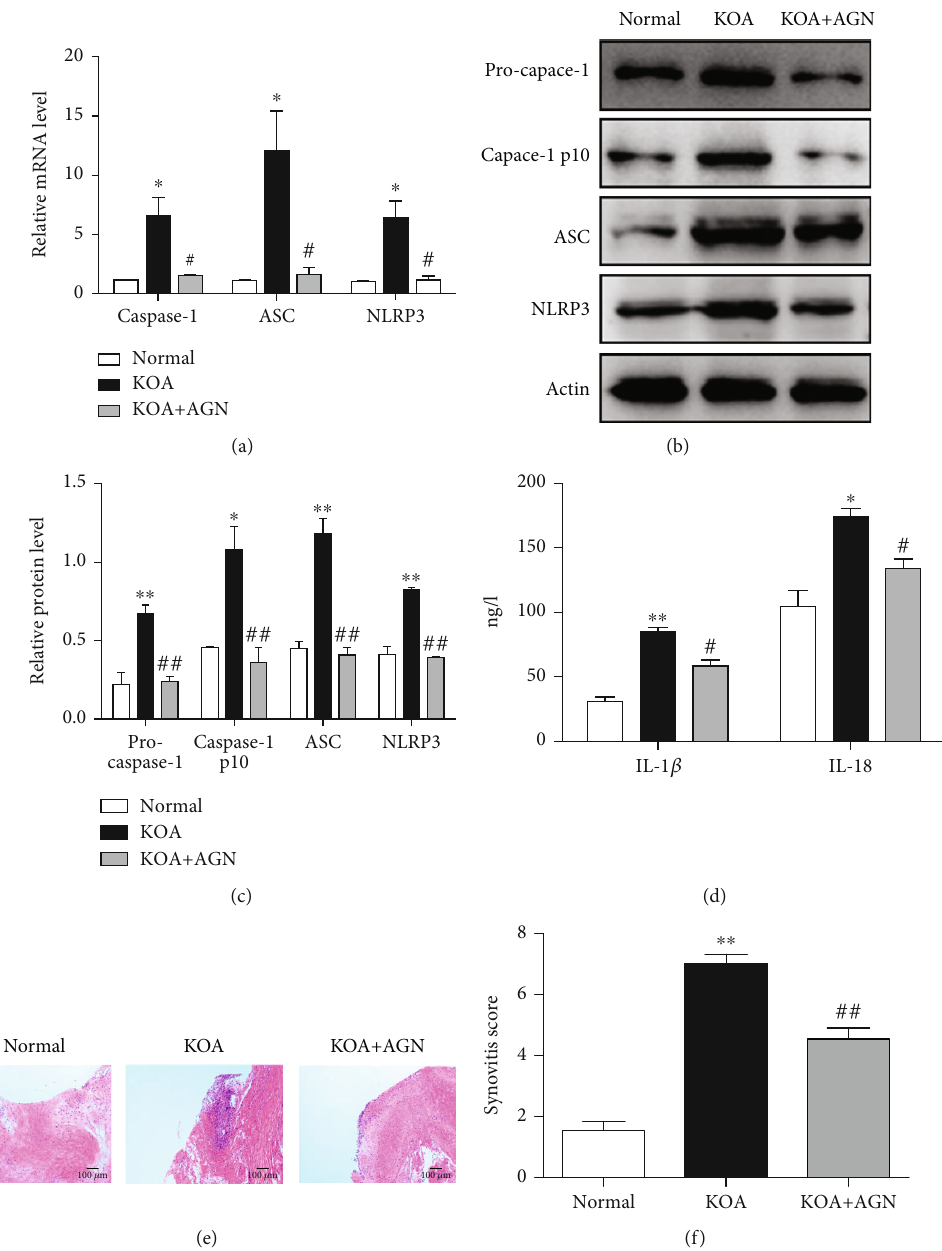
Figure 2: Agnuside may inhibit NLRP3 in fl ammasome and alleviate synovitis in KOA Rats. (a) mRNA levels of caspase-1, ASC, and NLRP3 in each group. ∗ P < 0 : 05 , in comparison with the normal group. # P < 0 : 05 , in comparison with the KOA group. (b) Typical protein bands for each group. (c) Protein level comparison of pro-caspase-1, caspase-1, p10, ASC, and NLRP3 between groups. ∗ P < 0 : 05 , ∗∗ P < 0 : 01 , compared with the normal group. ## P < 0 : 01 , compared with the KOA group. (d) Serum levels of IL-1 β and IL-18 between groups. ∗ P < 0 : 05 , ∗∗ P < 0 : 01 , compared with the normal group. # P < 0 : 05 , compared with the KOA group. (e) Representative synovial tissues of each group stained with stained with HE staining, 200x, scalebar = 100 μ m. (f) Synovitis score according to Kenn ’ s criteria. ∗∗ P < 0 : 01 , compared with the normal group. ## P < 0 : 01 , compared with the KOA